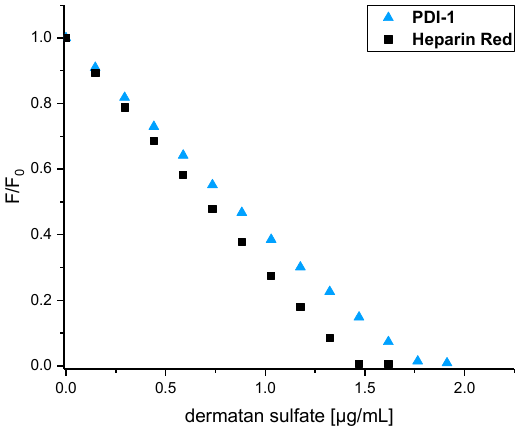
Figure 1. Normalized fluorescence response (F/F 0 ) of probes PDI-1 and Heparin Red to dermatan sulfate. Excitation at 550 nm, fluorescence emission recorded at 610 nm. A solution of 1 µM probe in 10 mM MOPS pH 7 was placed into a polymethyl methacrylate (PMMA) cuvette and “titrated” with 10 µL aliquots of a 25 µg/mL dermatan sulfate solution.